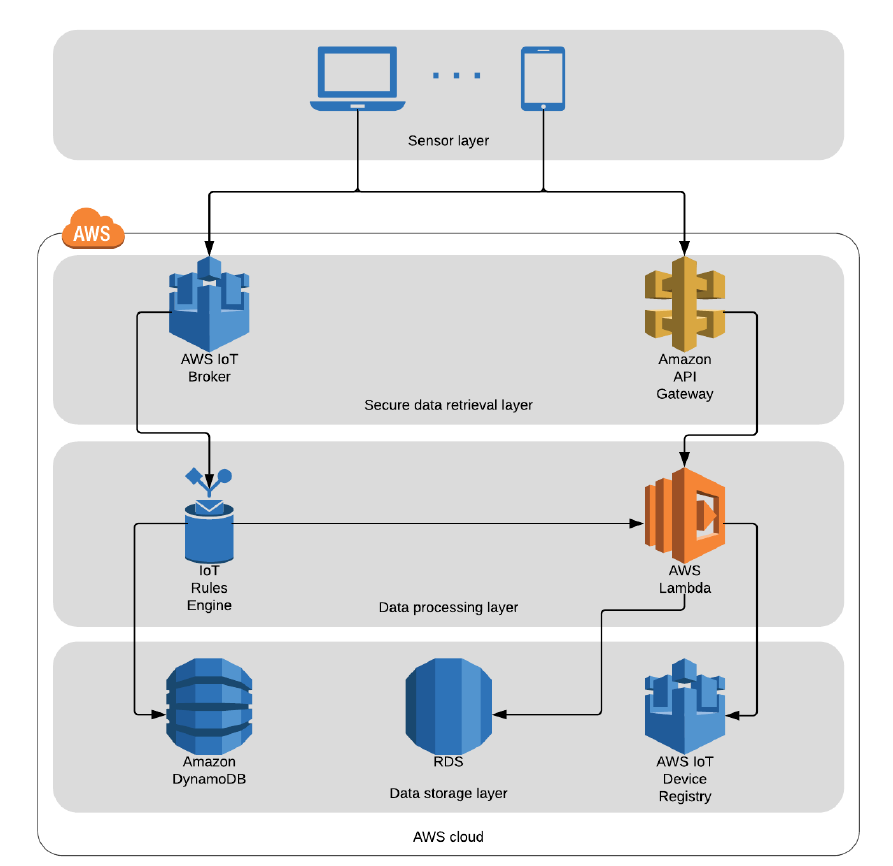
Figure 3. Prototype